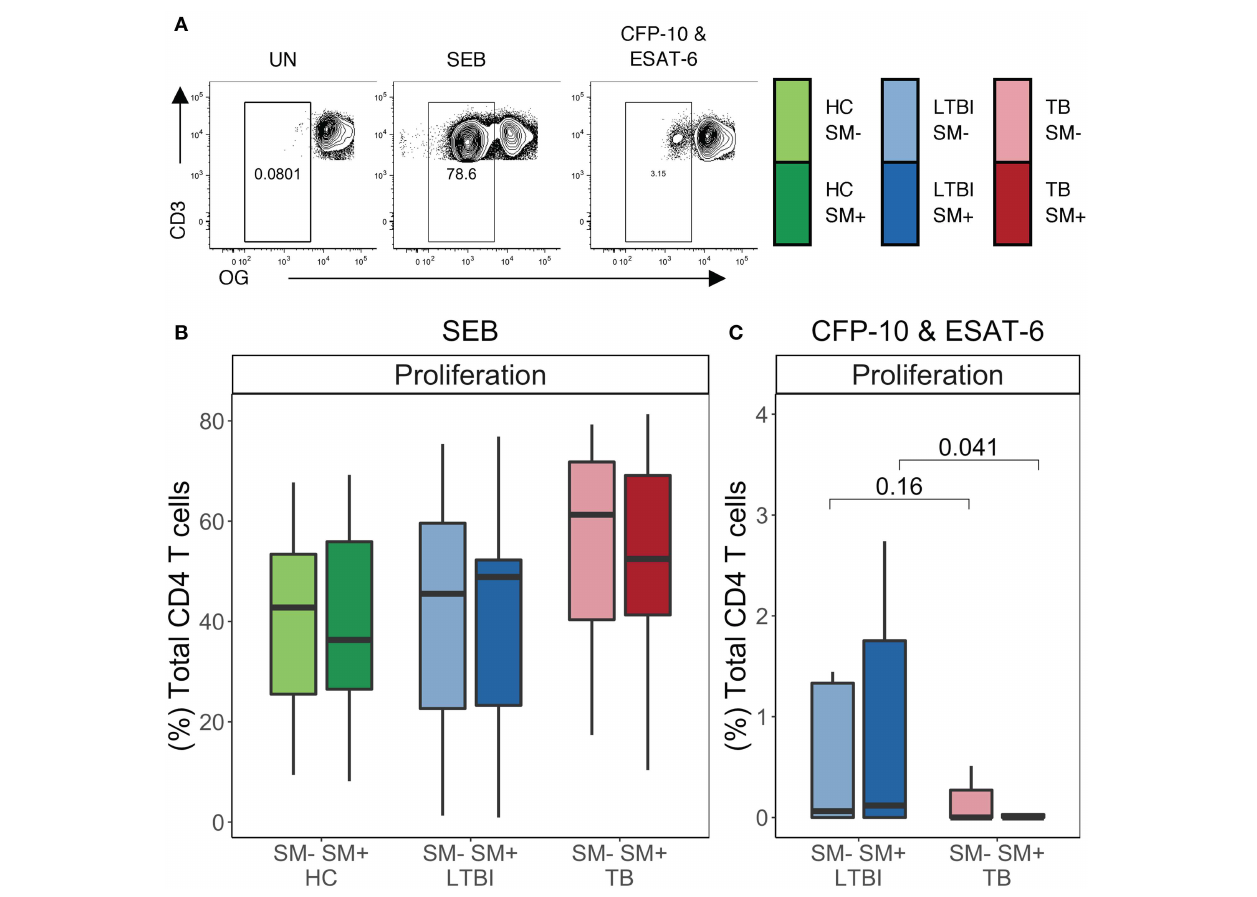
FIGURE 6 | Similar frequencies of CD4T cells proliferate in SM + and SM − individuals independent of Mtb infection status. Proliferation assays were performed using PBMC samples obtained from individuals in each of six groups defined by Mtb and SM infection status (HC SM − , n = 24; HC SM + , n = 13; LTBI SM − , n = 25; LTBI SM + , n = 25; TB SM − , n = 25; TB SM + , n = 15). Cells were labeled with Oregon Green (OG) and incubated for 5 days under the following conditions: media alone (negative control), SEB (positive control) or CFP-10 and ESAT-6 peptide pools. (A) Representative flow cytometry data from an SM + individual with LTBI. Plots show cells gated on live CD3 + CD4 + CD8 − lymphocytes. (B,C) Frequency of OG lo (proliferating) CD4T cells to SEB and CFP-10 and ESAT-6 peptide pools. Data are shown after subtraction of background proliferation in the unstimulated negative control condition. Boxes represent the median and interquartile ranges; whiskers represent the 1.5*IQR. Differences in the frequency of each CD4T cell population between SM + and SM − individuals were assessed using a Mann Whitney U